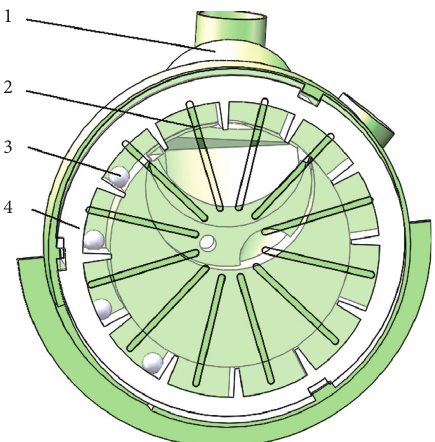
Figure 5: Cotton seeds in confined space. (1) Storage seed shell. (2) Air suction plate. (3) Cotton seed. (4) Guide groove plate.